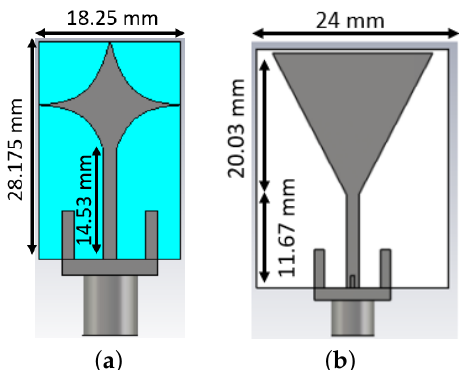
Figure 1. Dimensions of the substrate, patch and transmission line of ( a ) the spear patch antenna and ( b ) the triangular patch antenna. A 24.75 mm × 29.7 mm MTS superstrate loading was modelled to operate as